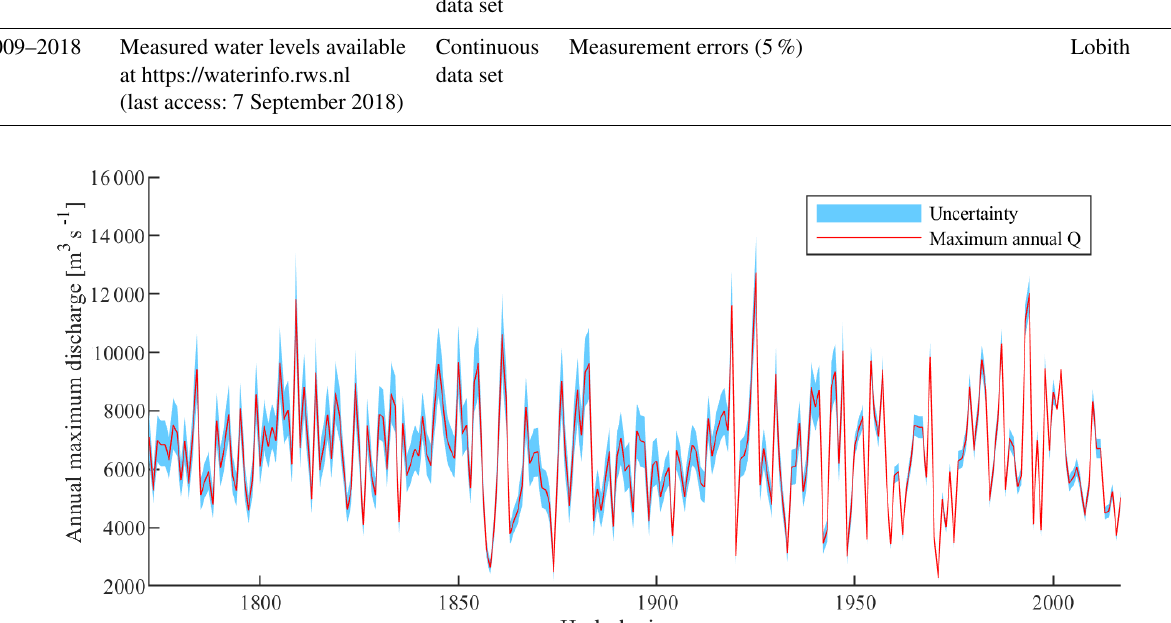
Figure 1. Maximum annual discharges ( Q ) and their 95% confidence interval during the systematic time period (1772–2018).